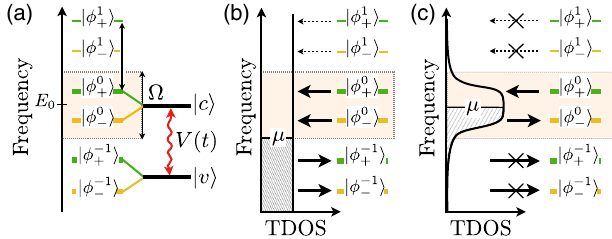
FIG. 2. Harmonic structure of Floquet states and energy-filtered reservoir coupling. (a) Floquet harmonics of a two-level system with states j v i and j c i coupled by an on-resonance driving field V ð t Þ . The Floquet zone (shaded) is centered at the energy E 0 , set equal to the energy of the resonant state j c i . In the special V 0 e − i Ω t j c ih v j þ H : c : , we have case of a rotating field V ð t Þ ¼ 1 2 j ϕ 0 i ¼ j c i , j ϕ − 1 i ¼ (cid:1)j v i , and E ¼ E 0 (cid:1) 1 2 V 0 ; see Eq. (3). (cid:1) (cid:1) (cid:1) Away from resonance, the relative normalizations of j ϕ n i and þ j ϕ n − i will change. For a more general form of weak driving, the dominant harmonics are shown in bold. (b) The Floquet states j ψ ð t Þi are both coupled to filled and empty states of a wide-band (cid:1) reservoir via the harmonics fj ϕ n ig ; see Eq. (10). Here, the (cid:1) reservoir chemical potential is set in the gap of the nondriven system. (c) When coupling is mediated by a narrow-band energy filter, the tunneling density of states (TDOS) and photon-assisted tunneling are suppressed outside the filter window. By setting the reservoir chemical potential inside the Floquet gap, centered around the energy E 0 in the original conduction band [see Fig. 1 (b)], the lower and upper Floquet bands are selectively filled and emptied,